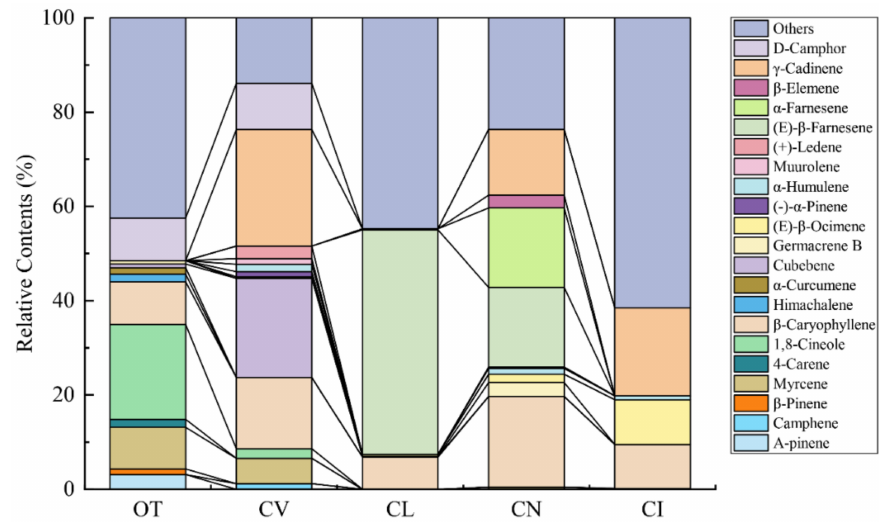
Figure 2. Major terpenoids (relative content > 1%) emitted from the five wild species.